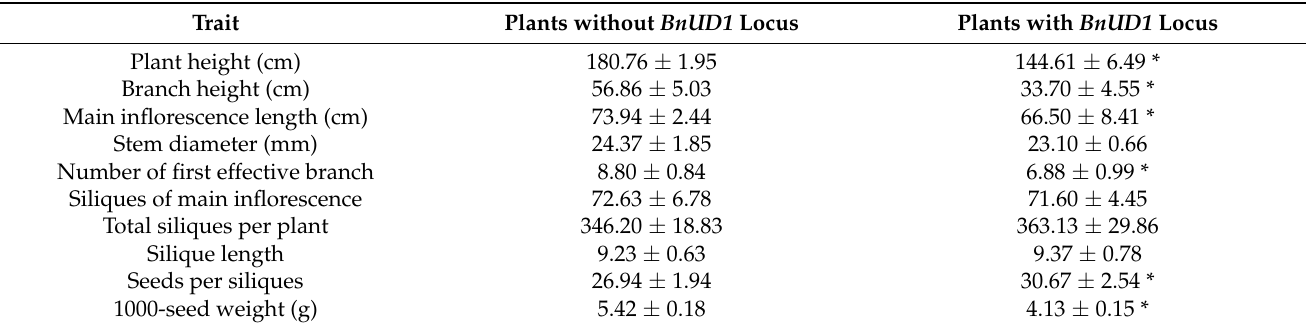
Table 3. Agronomic traits comparison between plants with BnUD1 locus and that without BnUD1 locus in the BC 6 F 2